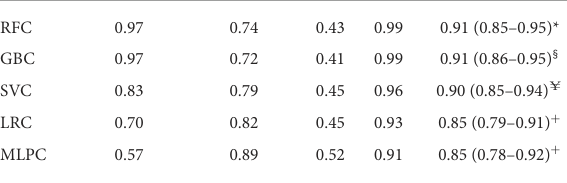
TABLE 2 Predictive performance metrics of different models in the testing